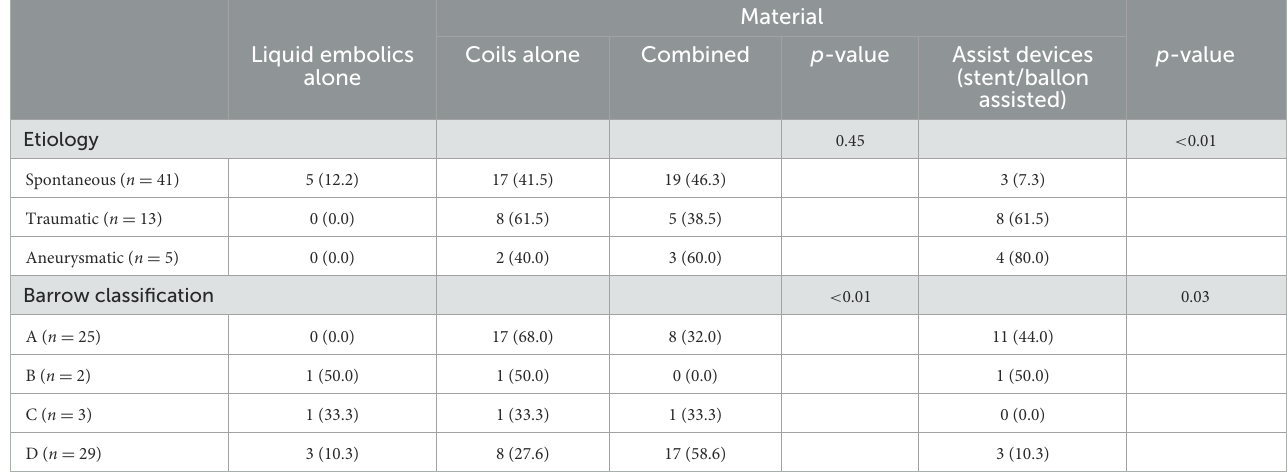
TABLE 3 Embolization material used regarding CCF etiology and fistula morphology.